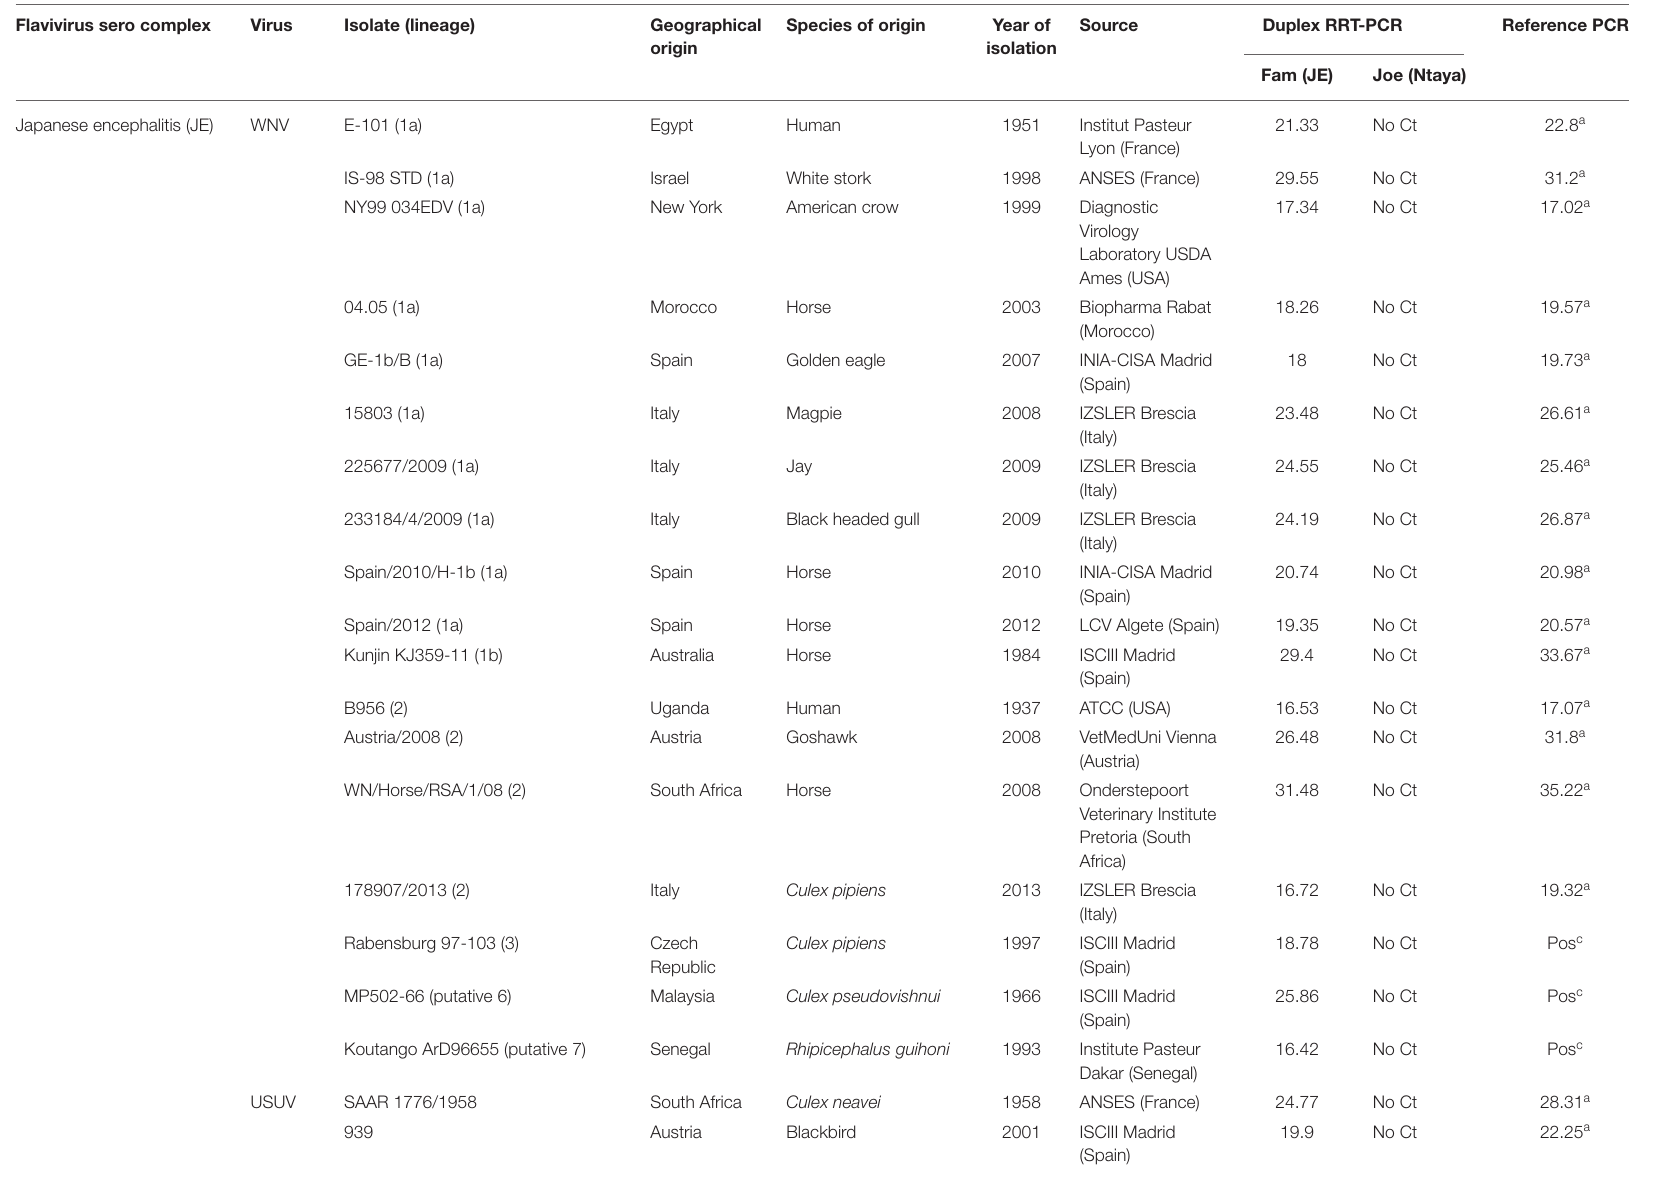
TABLE 1 | Flavivirus isolates used in this study and results obtained by the dRRT-PCR and the RT-PCR methods used as reference. Flavivirus sero complex Virus Isolate